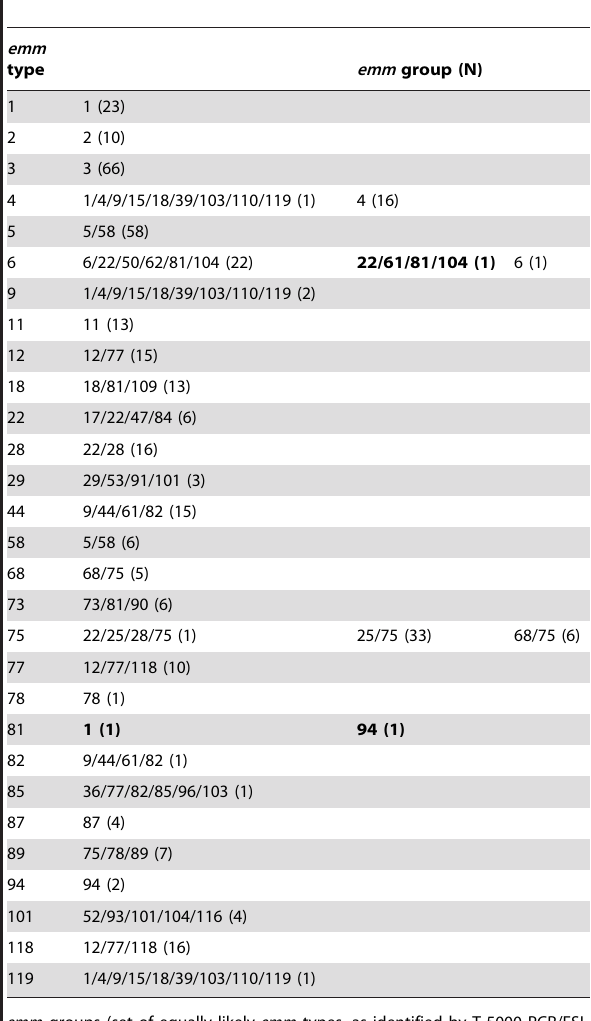
Table 2. Inverse relationships between emm groups and emm